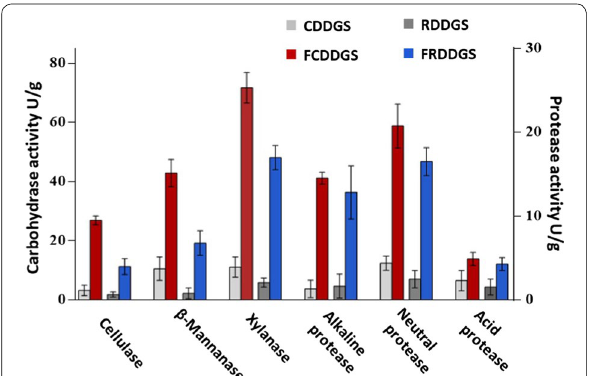
Fig. 1 Carbohydrase and protease activities of two DDGS before and after SSF. The activity of carbohydrase and protease are shown on the left and right longitudinal axis,